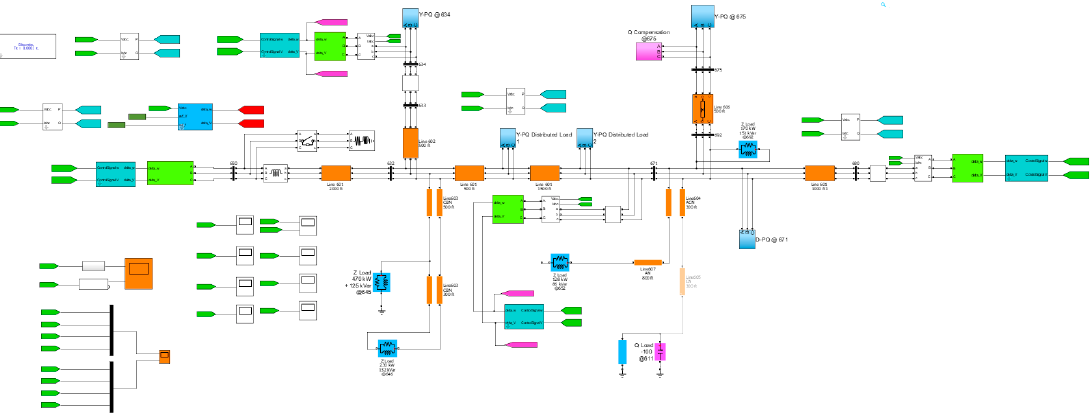
Figure 9. Microgrid test case based on IEEE 13-bus system.